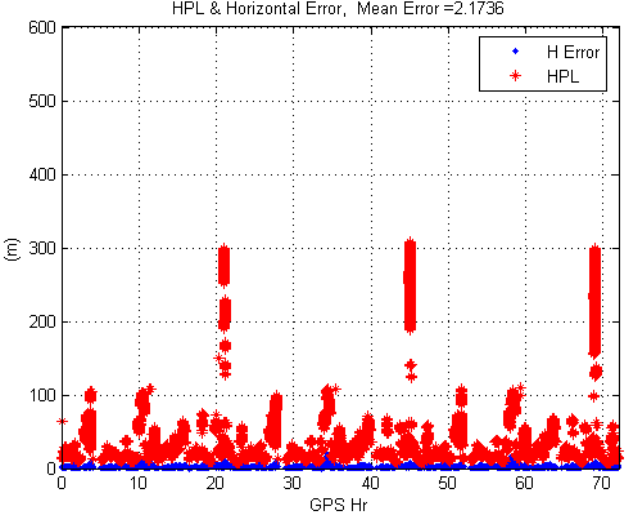
Figure 17. The HPL and horizontal positioning error